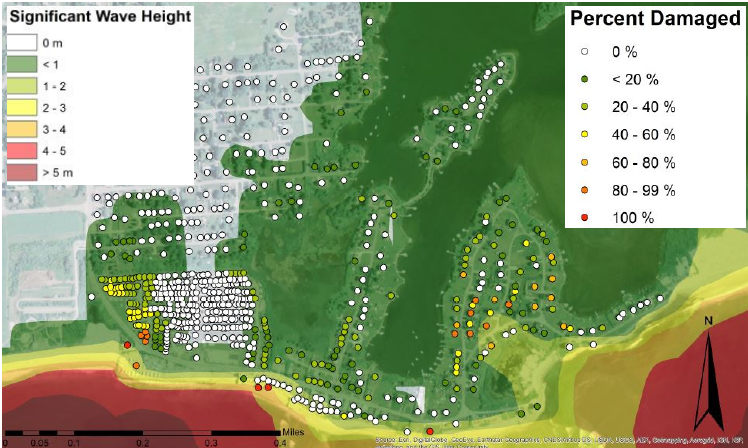
Figure 12. Estimated inundation damage to each structure from a 100 year storm event with no sea level rise using the “most likely” damage curves. Inundation depths from STORMTOOLS are also shown.